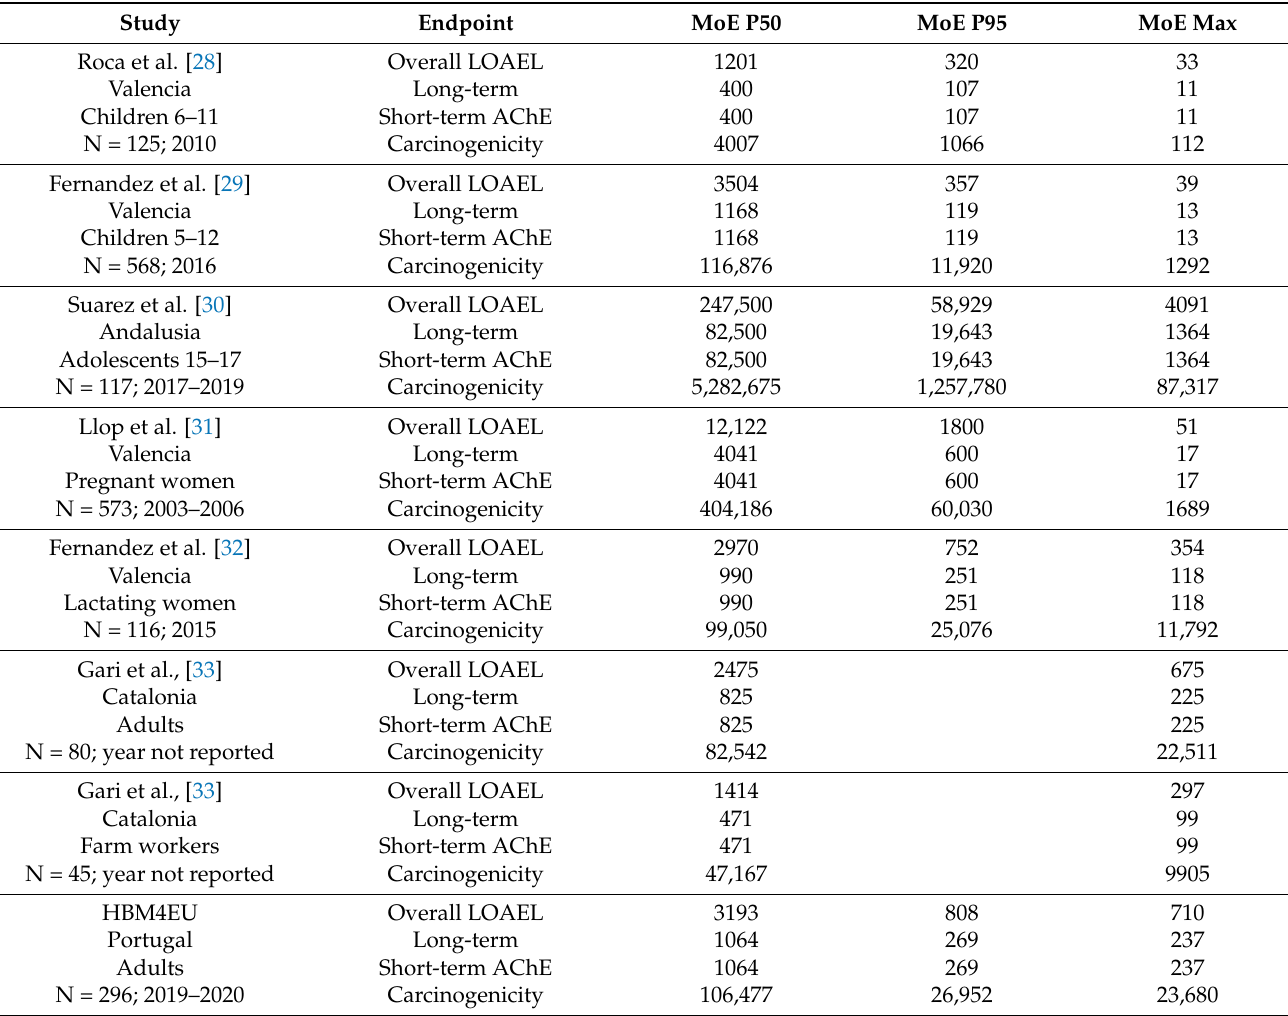
Table 4. Margins of exposure for the different endpoints estimated for the studies covering the Spanish population. HBM4EU data for Portugal are included for